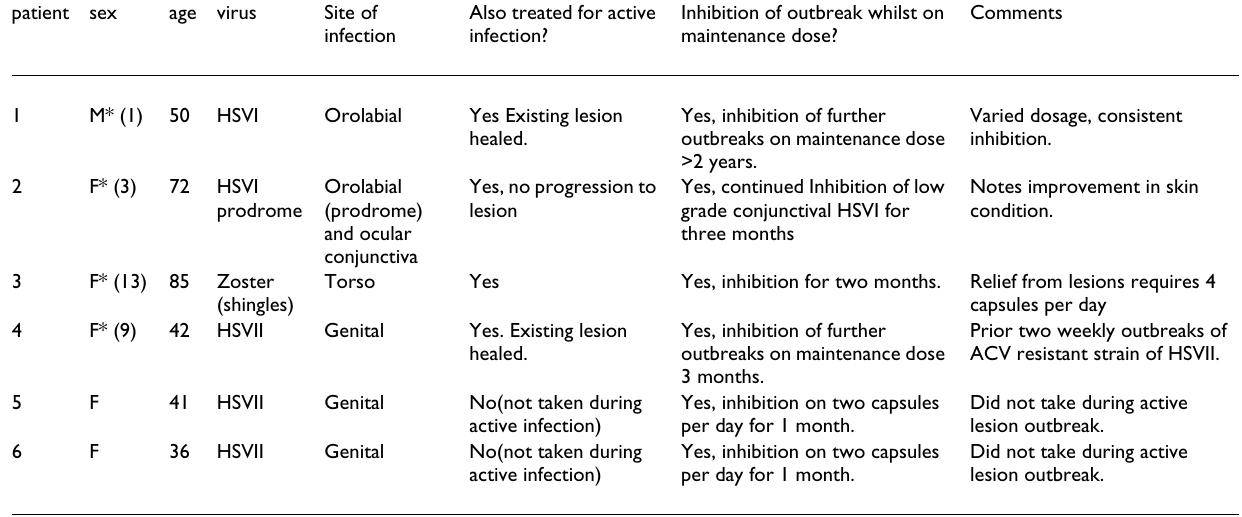
Table 2: Patients with latent Herpes infections. patient